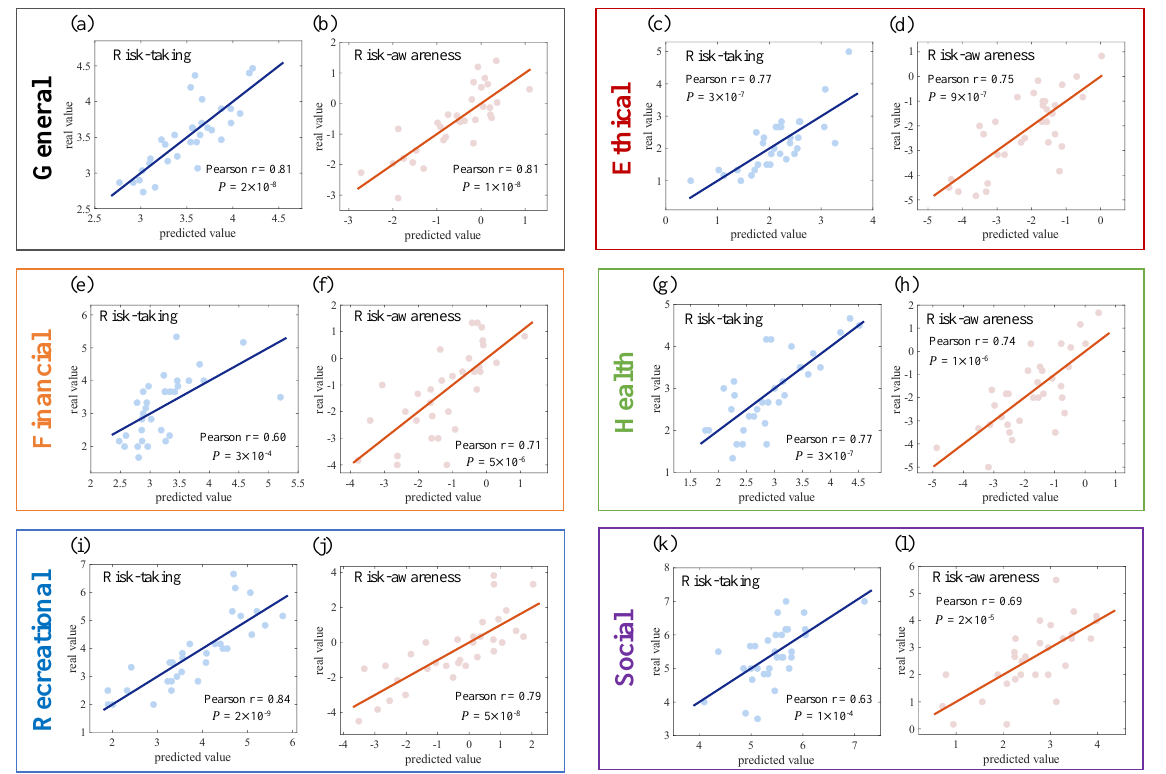
Figure 2. Comparison between the predicted risk-preference score and the real self-reported value ( N = 34) in the general ( a , b ), ethical ( c , d ), financial ( e , f ), health ( g , h ), recreational ( i , j ), and social domains ( k , l ). Each point corresponds to a specific participant. The predicted value is calculated by using significant predictors and the corresponding coefficients reported in Table